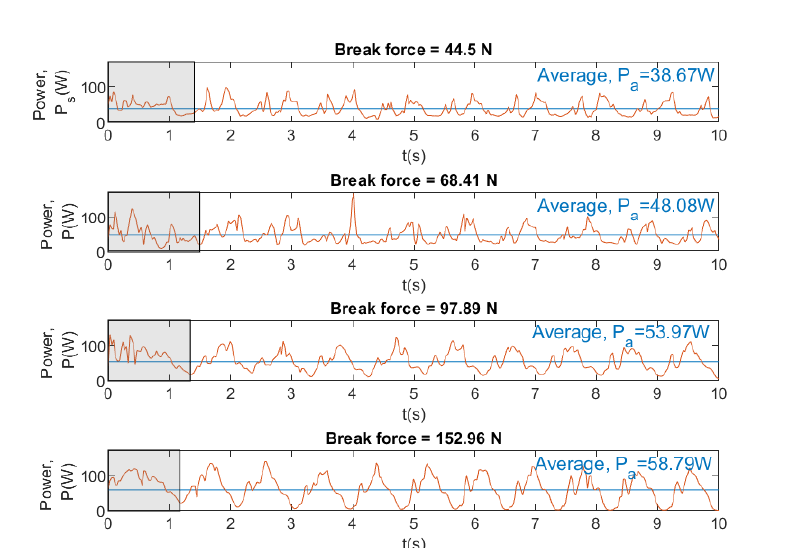
Figure 19. Instantaneous and average power for swimming stroke breaststroke at different brake forces.